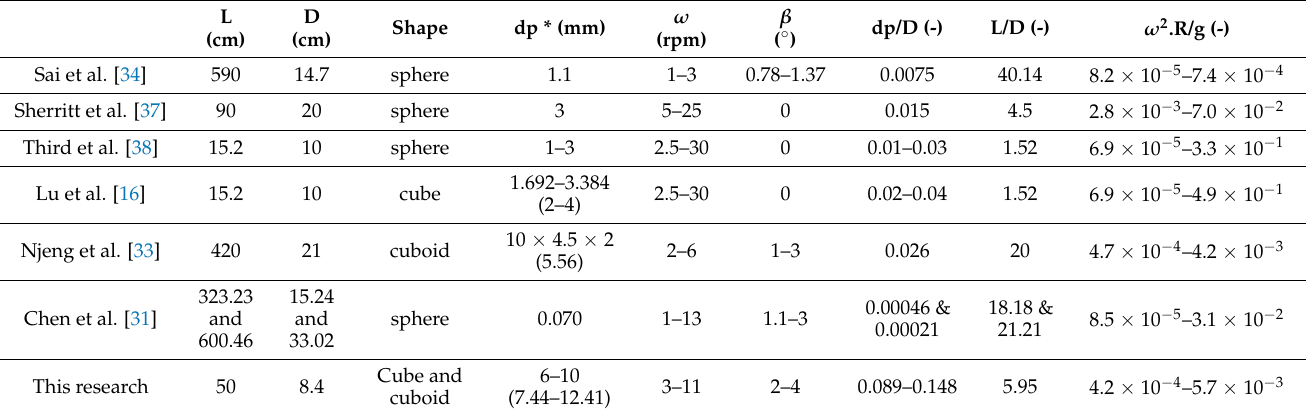
Table 3. Comparison between operating conditions, drum geometry and particle shape in the literature with this